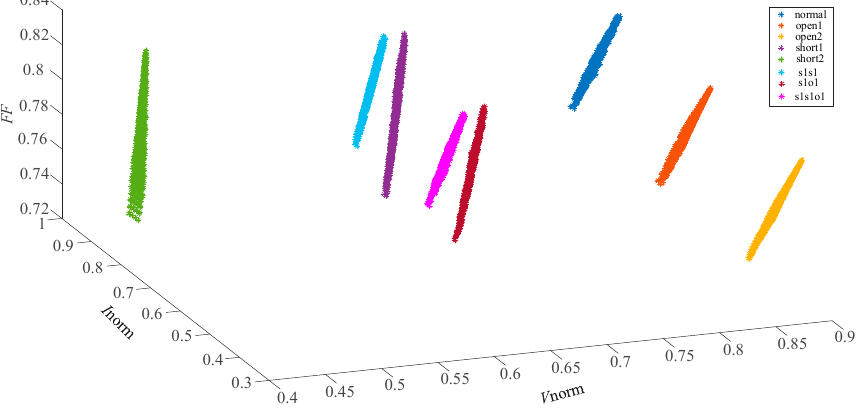
Figure 5. The distribution of the 8 faults characteristic points ( V norm , I norm , FF ) .